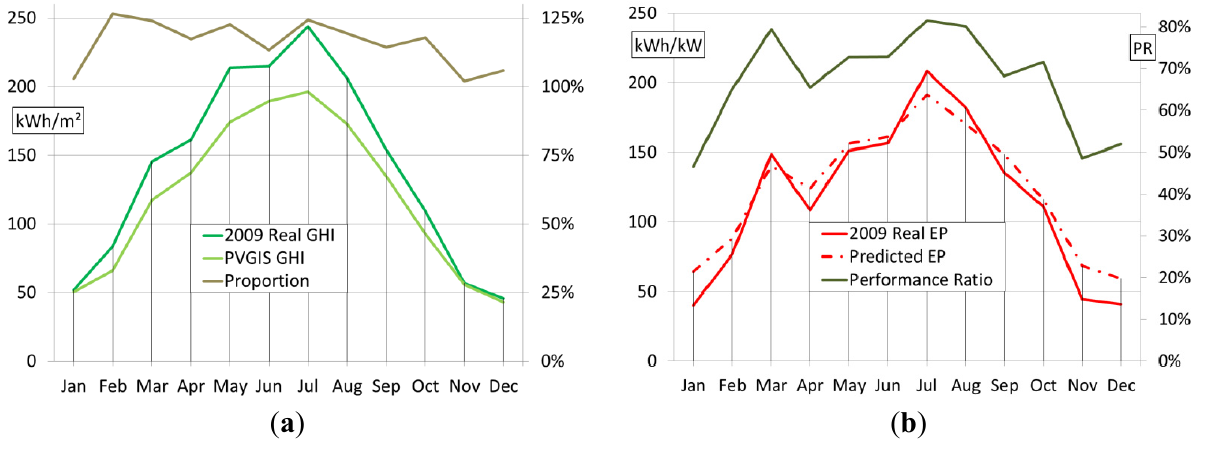
Figure 3. ( a ) Real GHI, PVGIS GHI, and real/PVGIS GHI in 2009; ( b ) Real EP, EP prediction based on constant PR, and estimated PR values for Villafranca CPV installation in 2009.